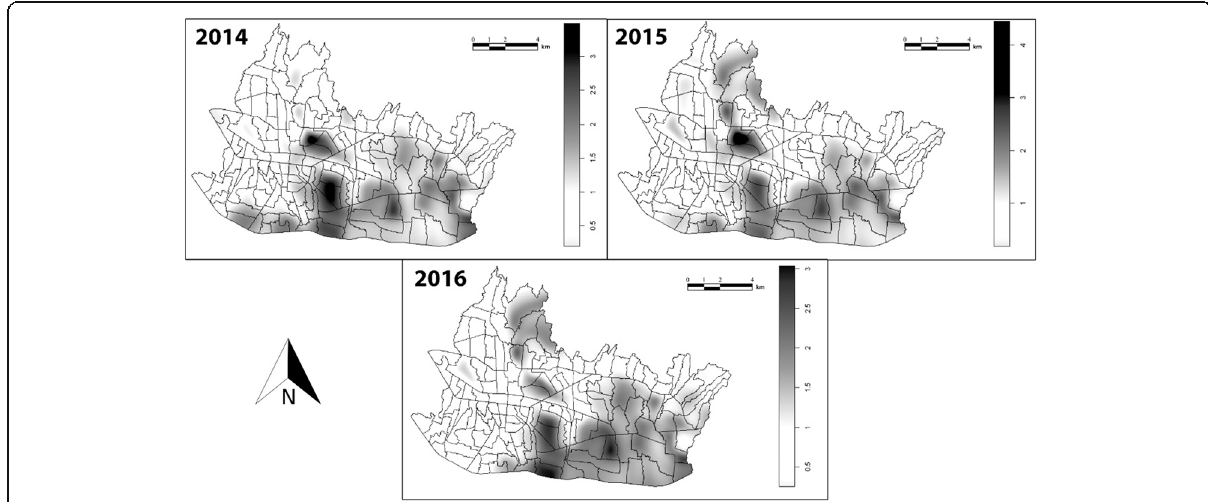
Fig. 6 Spatial analysis of the relative risk of dengue in Bandung at the village level in a 2014, b 2015, and c